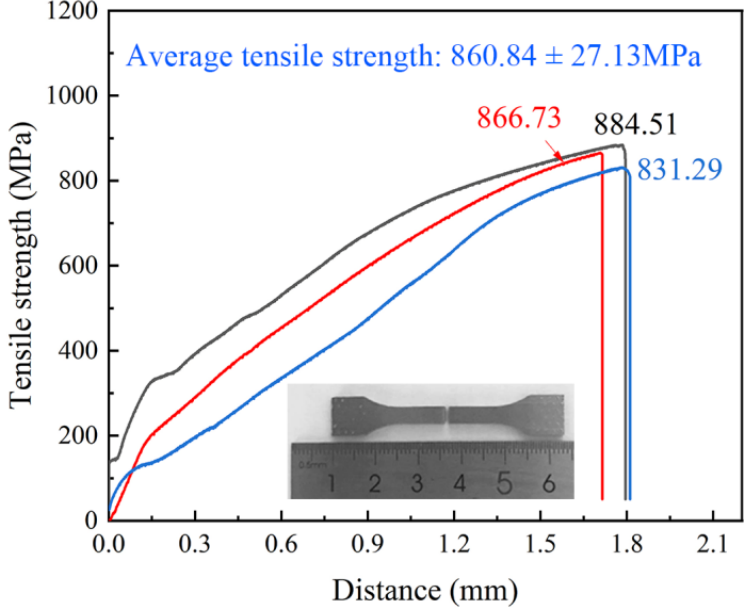
Figure 9. Tensile strength of TLP-diffusion-bonded joint using low-B interlayer.